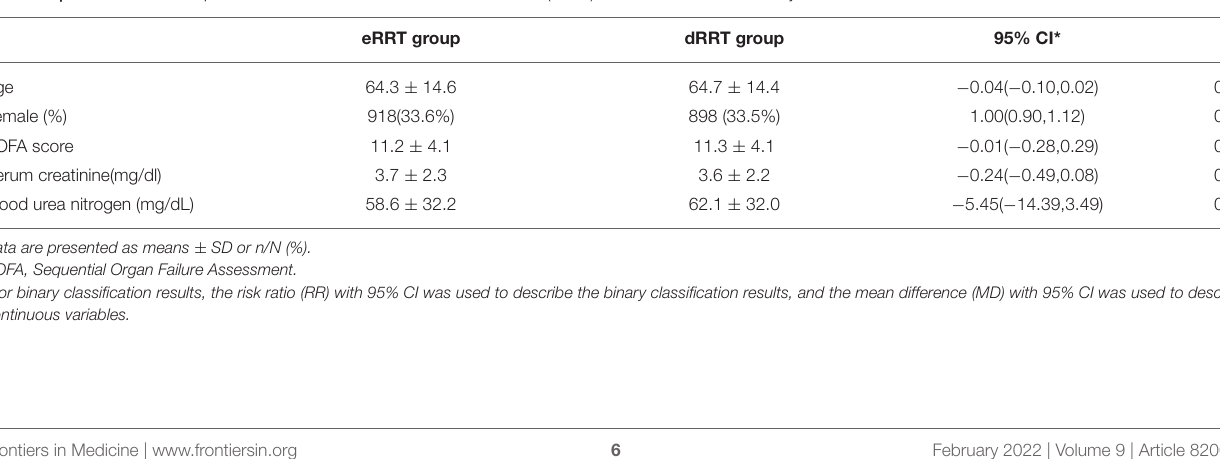
TABLE 3 | Characteristics of patients from the randomized controlled trials (RCTs) included in the